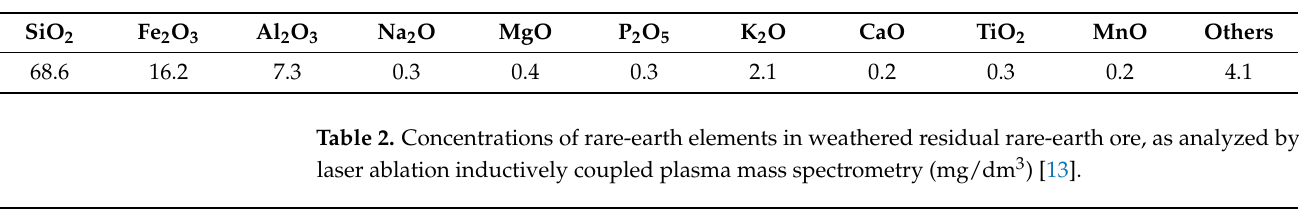
Table 1. Chemical composition of weathered residual rare-earth ore, as analyzed by X-ray fluorescence (mass %) [13].